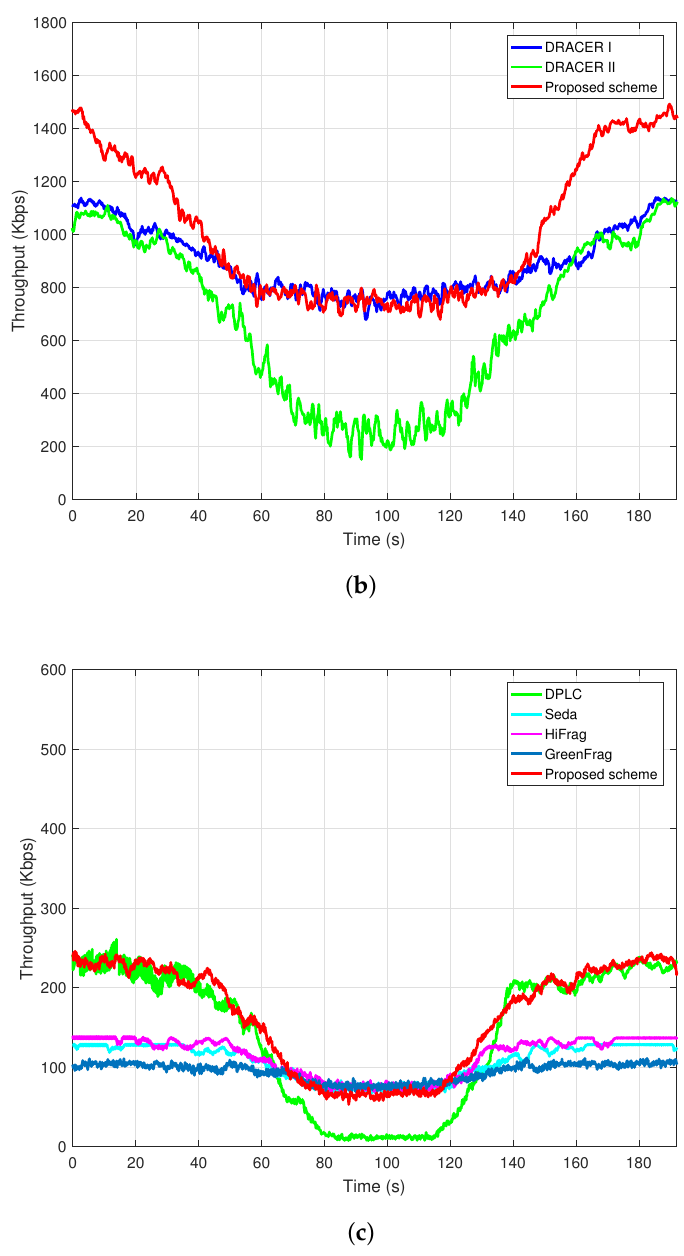
Figure 10. Transmission performance in the presence of mobile interference source. ( a ) Simulation scenario (without any shadowing); ( b ) Throughput according to time when the maximum R is 2 Mbps; ( c ) Throughput according to time when the maximum R is limited to 250